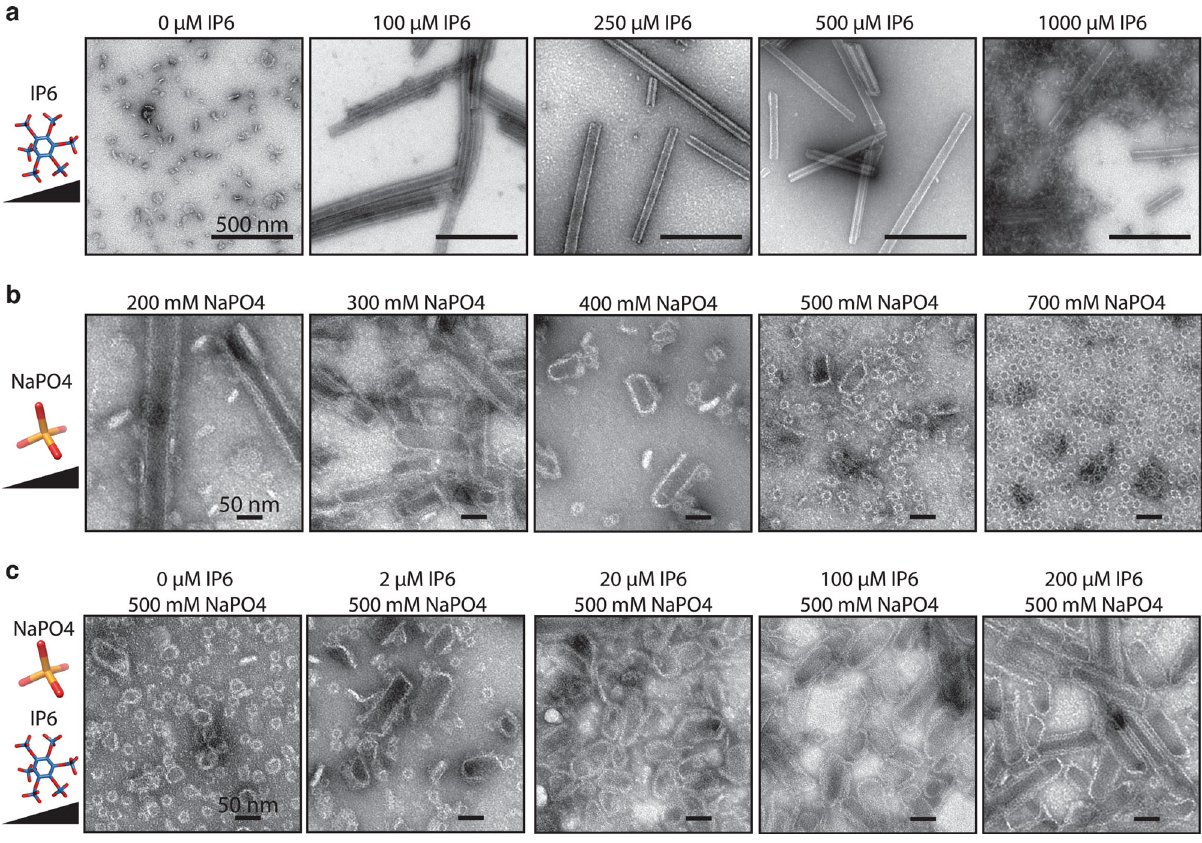
Fig. 4 Effect of NaPO 4 and IP6 on in vitro CA assembly. a Example TEM images of CA assembly reactions with increasing concentrations of IP6. b Example TEM images of CA assembly reactions with increasing concentrations of NaPO 4 . c Example TEM images of CA assembly with fi xed 500 µ M NaPO 4 and increasing concentration of